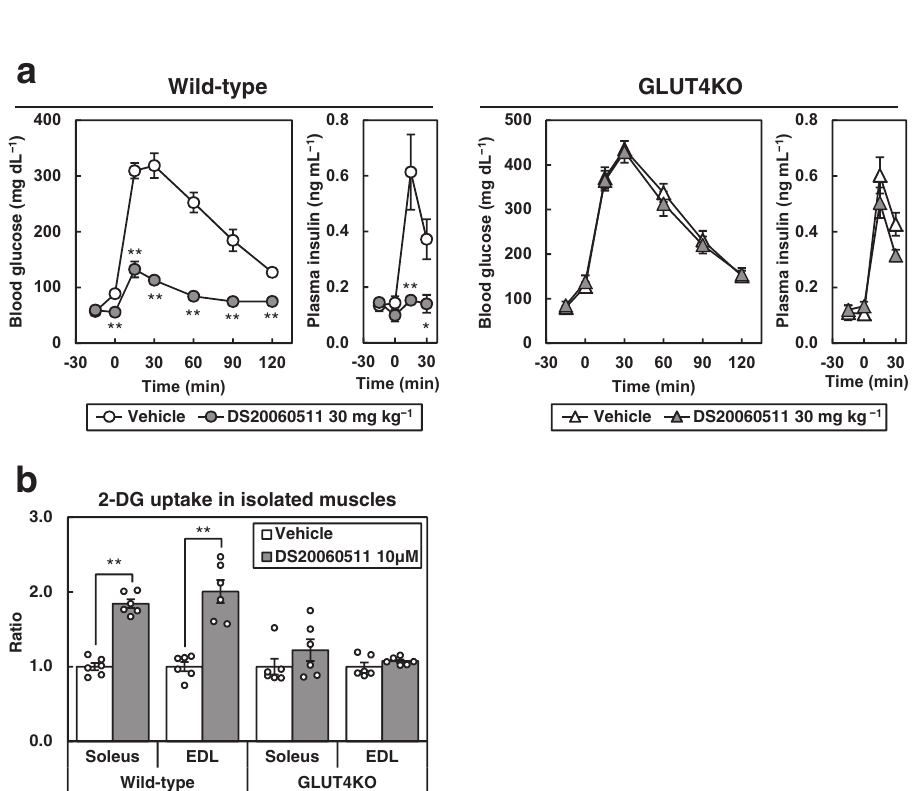
Fig. 2 Treatment with DS20060511 decreases the blood glucose levels via inducing GLUT4 translocation and increasing skeletal muscle glucose uptake. a , b Blood glucose levels after treatment with DS20060511 (30 mg kg − 1 ) in C57BL/6 mice that had received continued access to food ( a ) and mice that had been denied access to food overnight ( b ) ( n = 8). Values shown are means±SEM. ** P < 0.01 vs. 0 min by one-way ANOVA followed by Dunnett ’ s test. c Blood glucose and plasma insulin levels during oral GTT in the C57BL/6 mice (n = 5 – 6). The mice received oral administration of vehicle or DS20060511 at the indicated dose, 15min prior to glucose administration (1.5gkg − 1 ). Values shown are means ±SEM. * P < 0.05, ** P < 0.01 vs. vehicle by one-way ANOVA followed by Williams ’ test. d [ 3 H]-2-DG uptake in the soleus muscle, gastrocnemius muscle (Gastro.), heart, and white adipose tissue (WAT) at 60min during the intraperitoneal GTT in the C57BL/6 mice ( n = 3). The mice received oral administration of vehicle or DS20060511 (30 mg kg − 1 ), 15min prior to glucose administration (1gkg − 1 glucose containing [ 3 H]-2-DG). Values shown are means ±SEM. * P <0.05, ** P < 0.01 vs. vehicle by the t -test. e Protein levels of GLUT4 and Na,K-ATPase α in the plasma membrane fraction of the triceps surae muscle excised from the C57BL/6 mice ( n = 2) treated with DS20060511 (10mgkg − 1 ), insulin (5 U kg − 1 ), or saline as vehicle, via the inferior vena cava 10min after the treatment. Uncropped blots for e can be found in Supplementary Fig. 6.